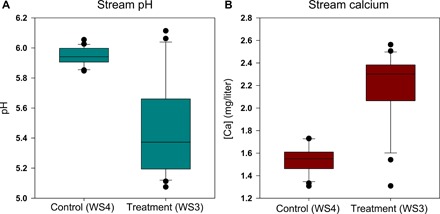
Impacts of intensified acidification on stream pH and calcium concentration.Distribution of stream water pH (A) and calcium concentration (mg/liter) (B) from 1989 to 2012 for both the treatment (WS3) and control (WS4) watersheds. Median value represented by horizontal black bar. Filled circles outside of the first and fourth quartile error bars denote statistical outliers.